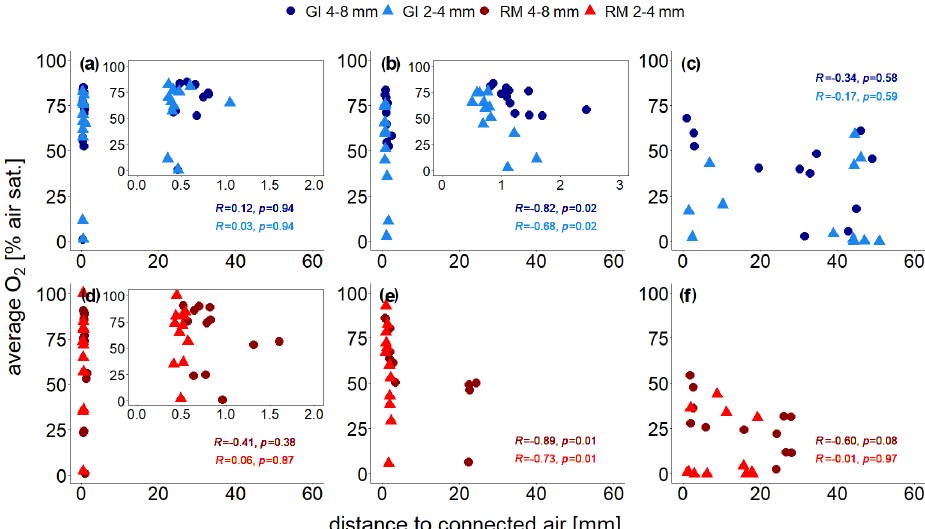
Figure 6. Average O 2 saturation (at the end of incubation experiment) measured with four sensors, each located at the centre of the soil core, as a function of distance to visible connected air for two repacked aggregate sizes (2–4 and 4–8mm) from Gießen (GI; a–c ; blue) and Rotthalmünster (RM; d–f ; red) soil. Panels (a) and (d) show results for the lowest (63% or 65% WFPS with GI and RM soil, respectively), (b, e) for medium (75% or 78% WFPS with GI and RM soil, respectively), and (c, f) for the highest (85% or 88% WFPS with GI and RM soil, respectively) water saturation. The insets in (a) , (b) , and (d) show a reduced distance range. The distance to visible connected air is averaged in a spherical region around the sensor tip (7.2mm diameter). The Spearman’s rank correlation coefficient ( R ) indicates the extent of monotonic relation between the ranks of both variables. The associated p values ( p ) were corrected for multiple comparison according to Benjamini and Hochberg